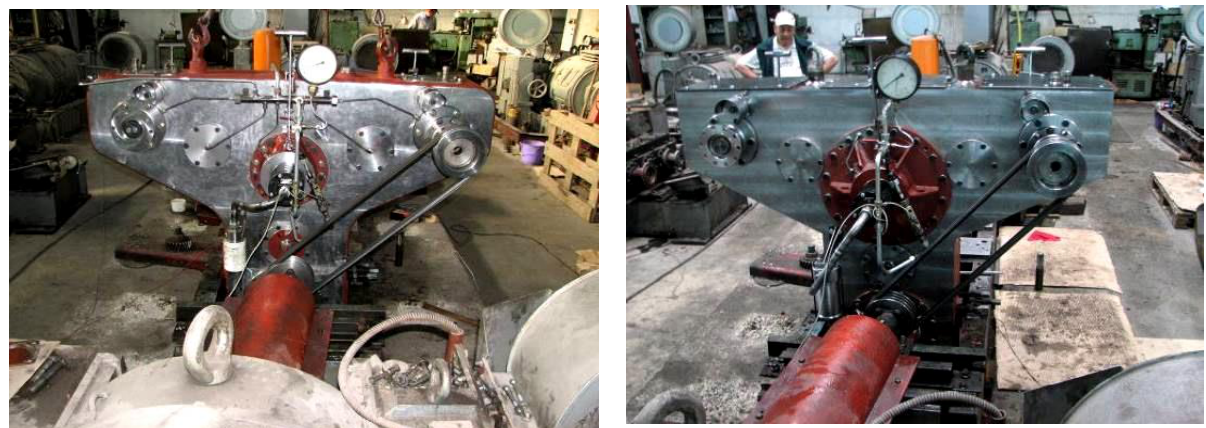
Figure 20. Old and new adder and distribution box mounted on the stand.